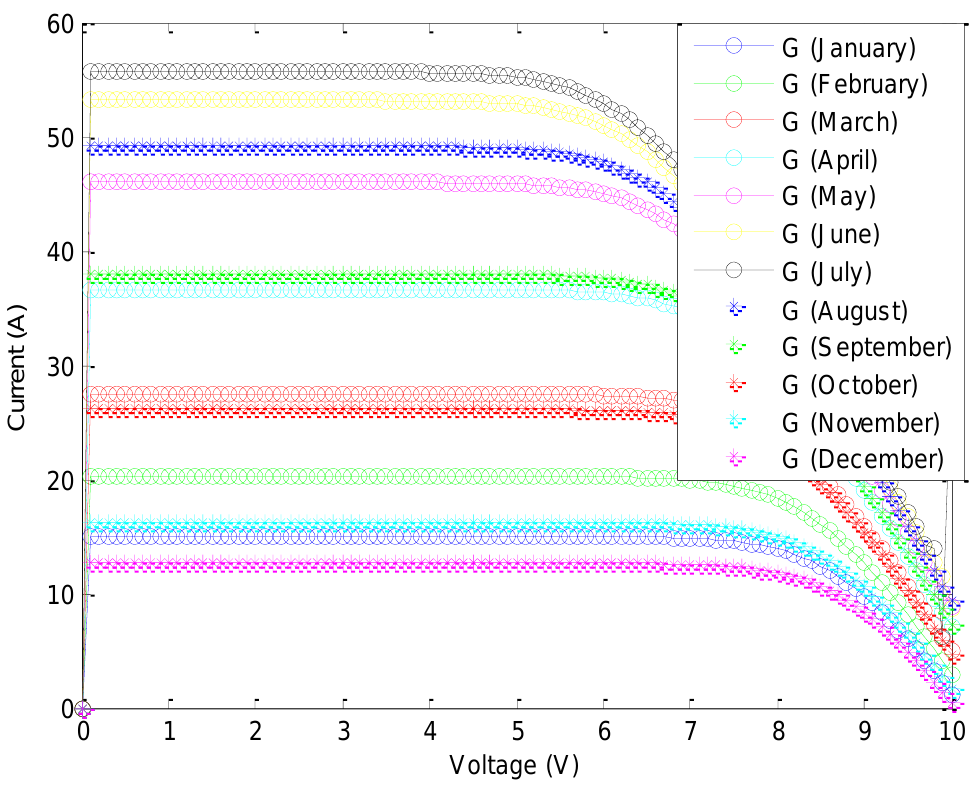
Figure 7. Current-voltage characteristic curves of photovoltaic cell for various irradiation and constant temperature in Tirana, Albania.